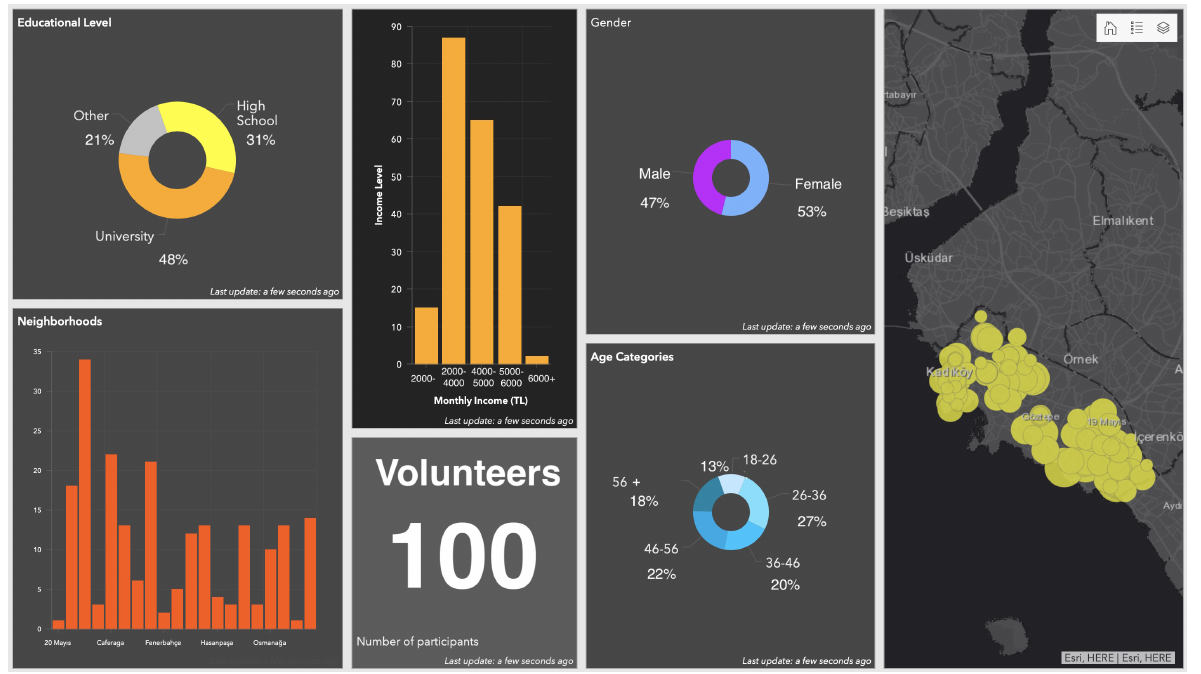
Figure 6. Socio-demographic characteristics of volunteers—a screenshot from dashboard of Sur- vey123 (Figure was created by using Survey123 system of ESRI